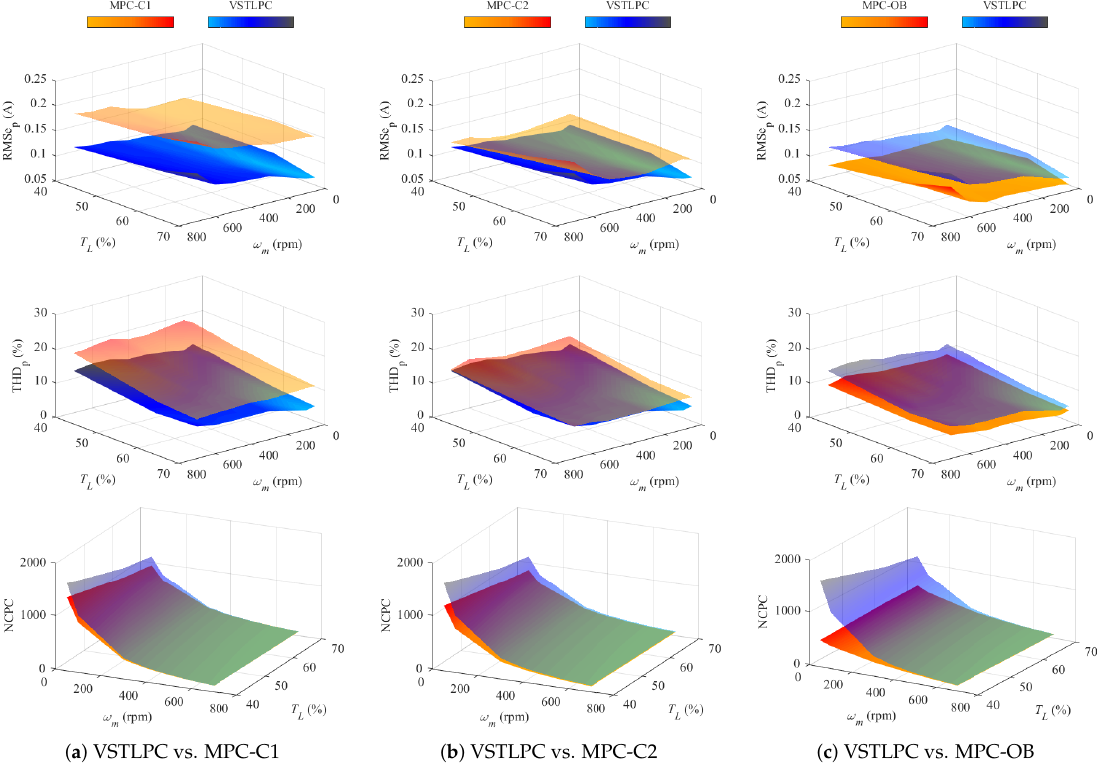
Figure 3. Experimental root mean square error of phase currents (RMSe p ), total harmonic distortion (THD) and number of commutations per cycle (NCPC) values for each controller under different operating